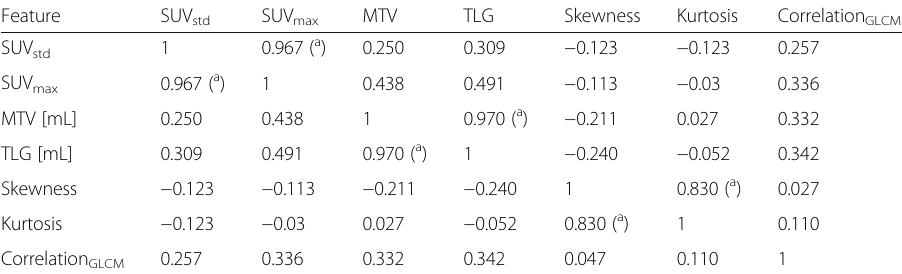
Table 5 Summary of the mutual correlation between features pre-selected as significant predictors Feature SUV std SUV max MTV TLG Skewness Kurtosis Correlation GLCM